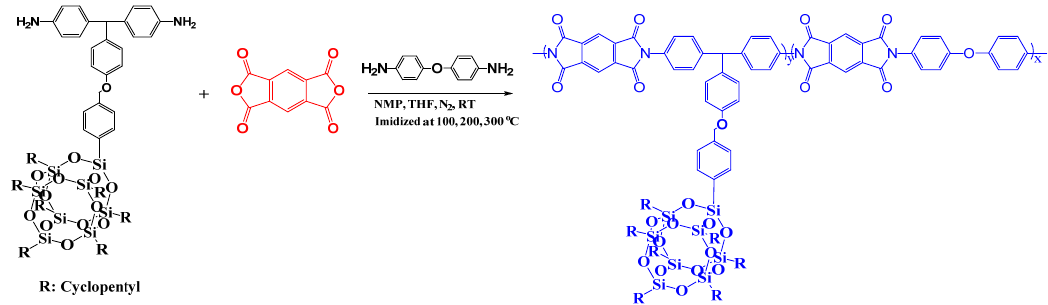
Figure 8. Schematic representation of side chain-tethered PI/POSS nanocomposites [78]. Reproduced with permission from the American Chemical Society.